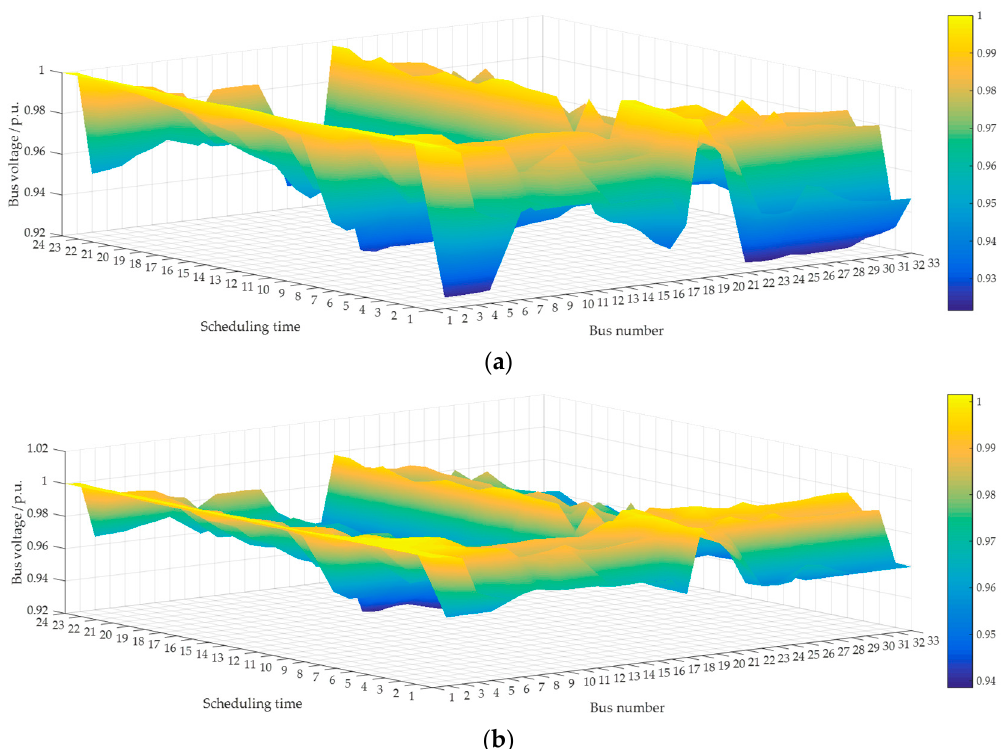
Figure 11. Uncertain range of daily voltage profile curve: ( a ) lower limit of daily voltage profile, and ( b ) upper limit of daily voltage profile.